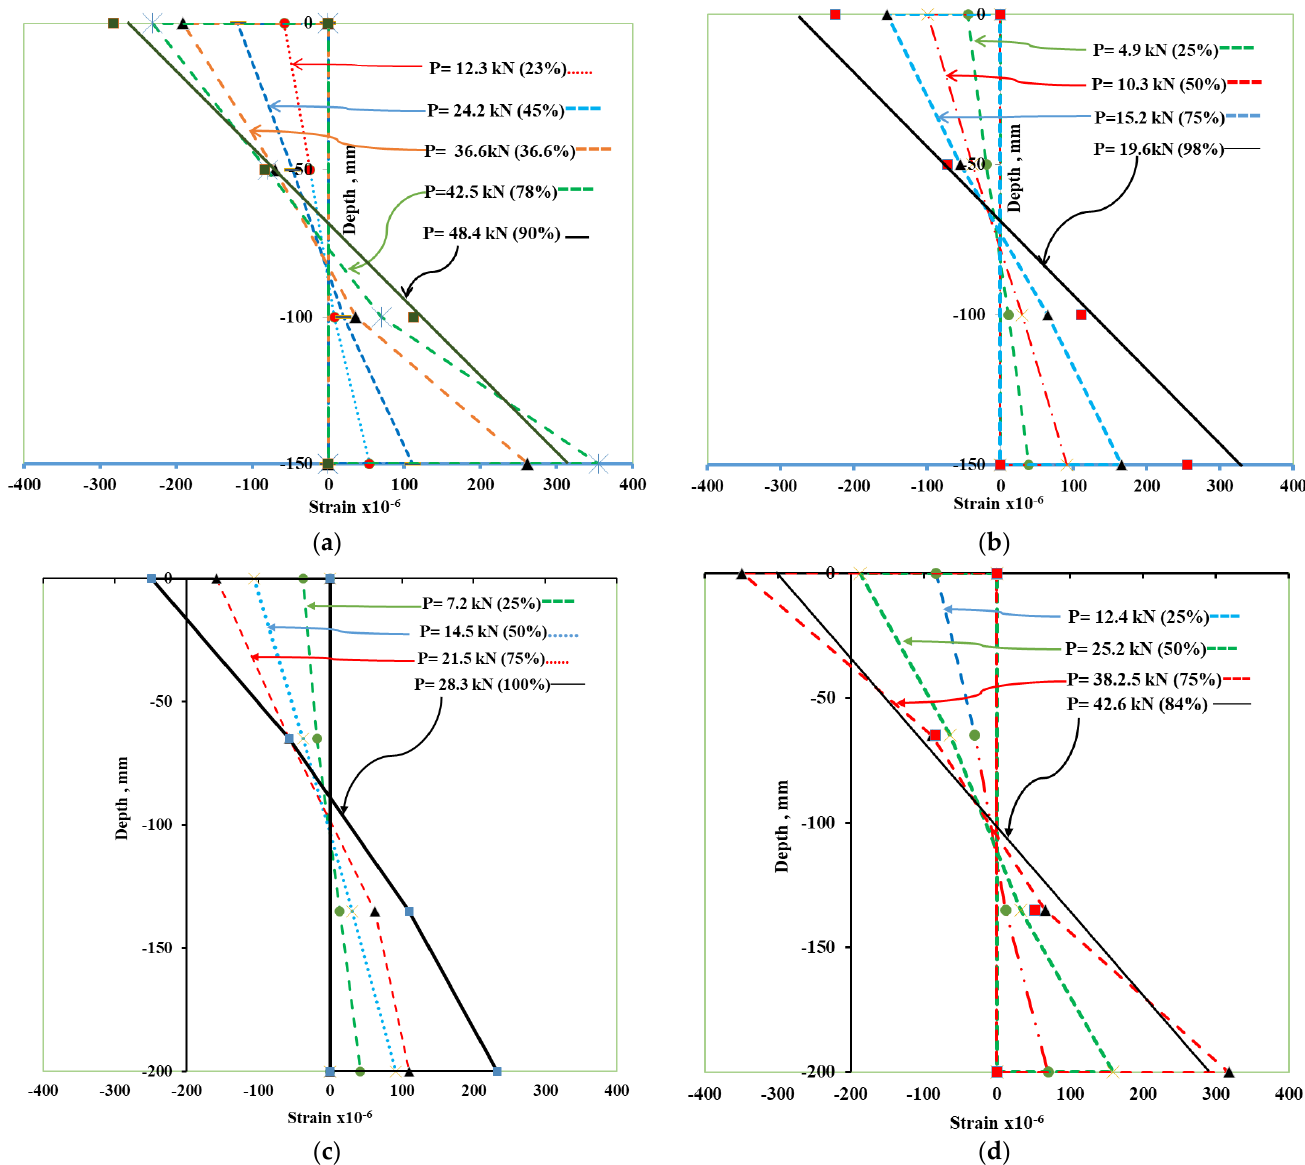
Figure 11. Strain diagram through the depth of hybrid beam: ( a ) beam A20, ( b ) beam B20, ( c ) beam D25, and ( d ) Beam D50.